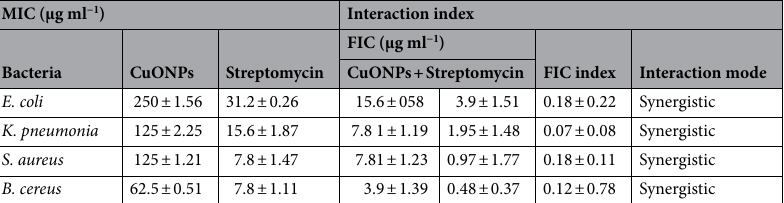
Table 2. Minimum inhibitory concentration (MIC) against pathogenic bacteria alone and in combination with antibiotic (streptomycin) along with interaction index. Experiments were performed in triplicates; mean ± SD are shown. Average of three independent determinations.